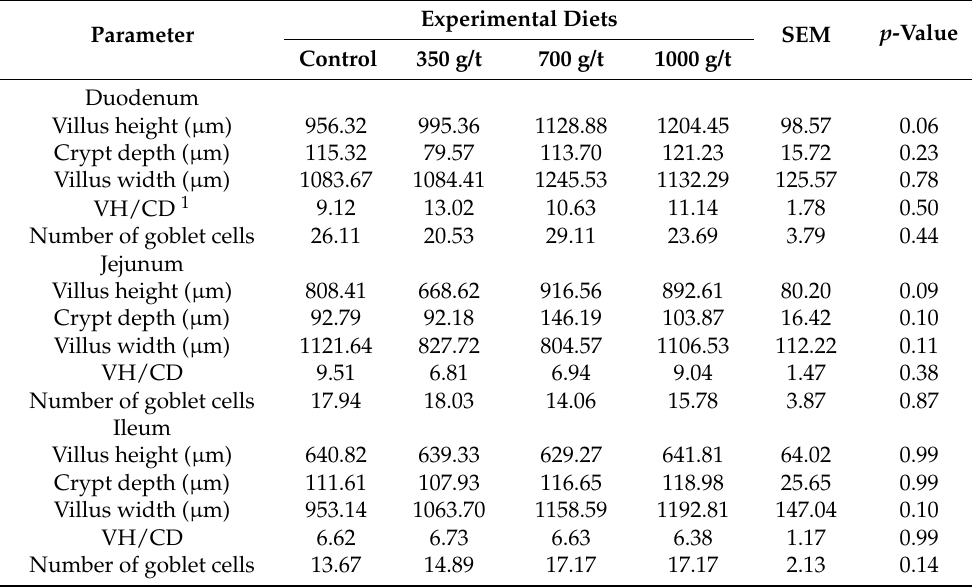
Table 5. The effects of Natuzyme dose rates on gut morphology of 42-day old broiler